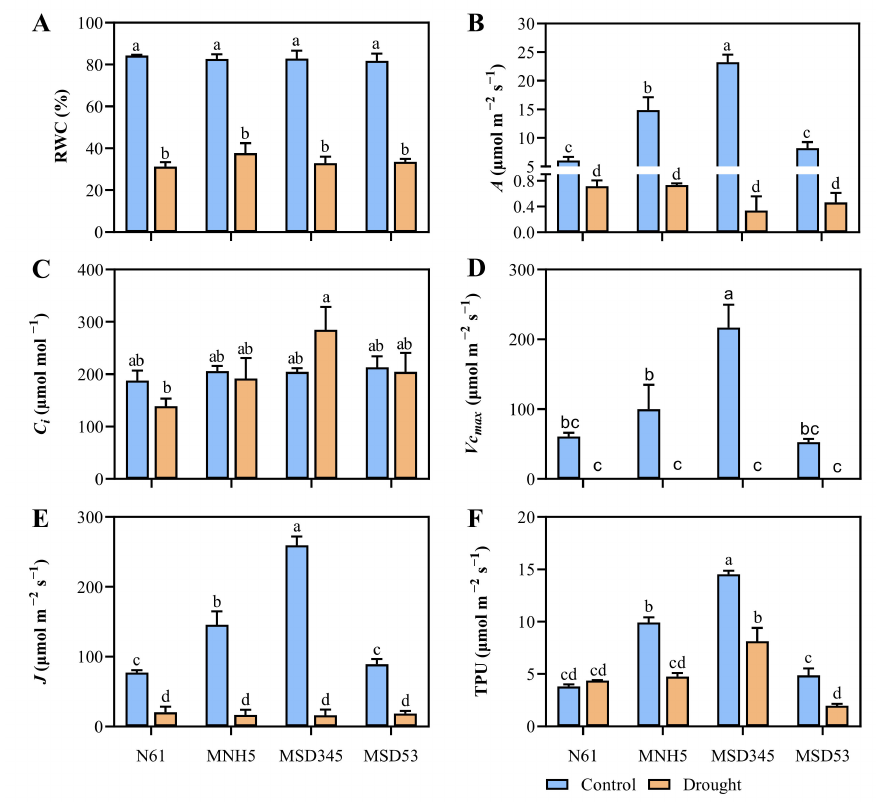
Figure 1. Comparative analyses of relative water content (RWC) and photosynthetic parameters of three multiple synthetic derivative lines and their backcross parent, “Norin 61” (N61), under control and drought stress conditions: ( A ) RWC, ( B ) CO 2 assimilation rate ( A ), ( C ) intercellular CO 2 concentration ( C i ), ( D ) maximum rubisco carboxylation rate ( V cmax ), ( E ) electron transport rate ( J ), and ( F ) triose phosphate utilization (TPU). Data represent mean of three independent biological replicates at 400 µ mol mol − 1 CO 2 concentration. Error bars represent standard deviation. Values marked with the same letter are not significantly di ff erent ( p < 0.05) between genotypes and conditions according to Tukey’s HSD